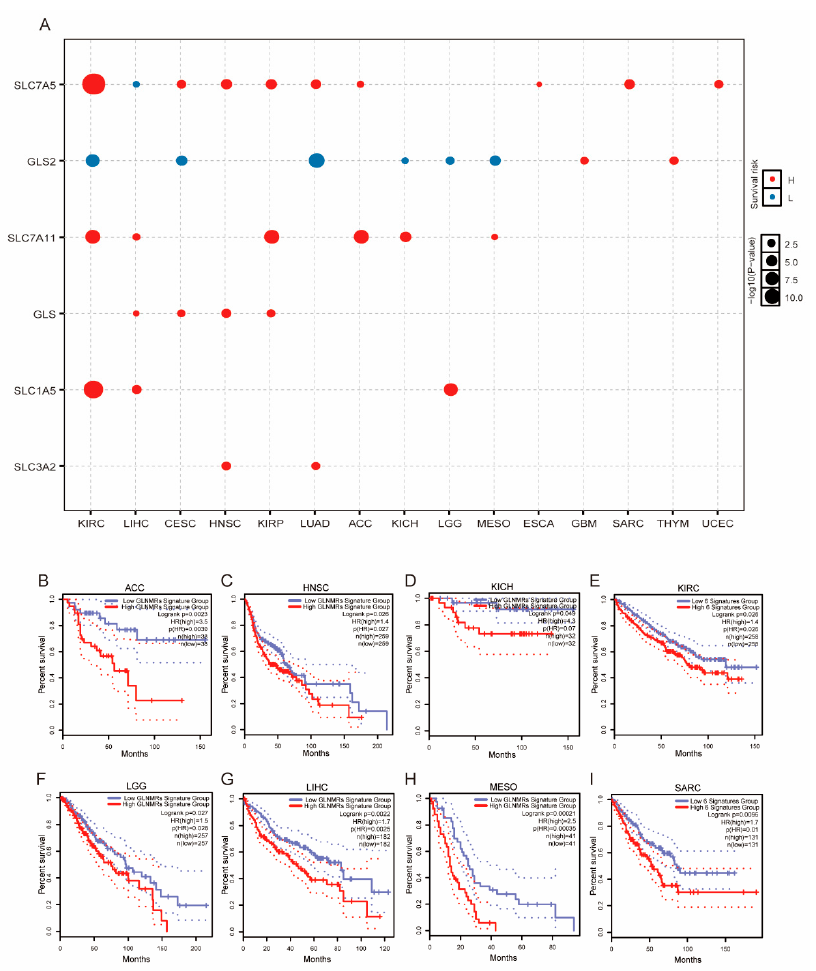
Figure 5. Glutamine metabolism (GLNM) regulator expression associated with prognosis in pan- cancer: ( A ) Heatmap displaying the − log10( p -value) of univariate Cox proportional hazards regres- sion between GLNM regulator expression and overall survival (OS). Blue dots represent low-risk genes and red dots represent high-risk genes. The sizes of the dots represent significance. ( B – I ) KM plot showing the differences in overall survival between patients in low- and high-GLNMR signature group for ( B ) ACC, ( C ) HNSC, ( D ) KICH, ( E ) KIRC, ( F ) LGG, ( G ) LIHC, ( H ) MESO and ( I ) SARC (all p < 0.05). Significance indicated by log-rank